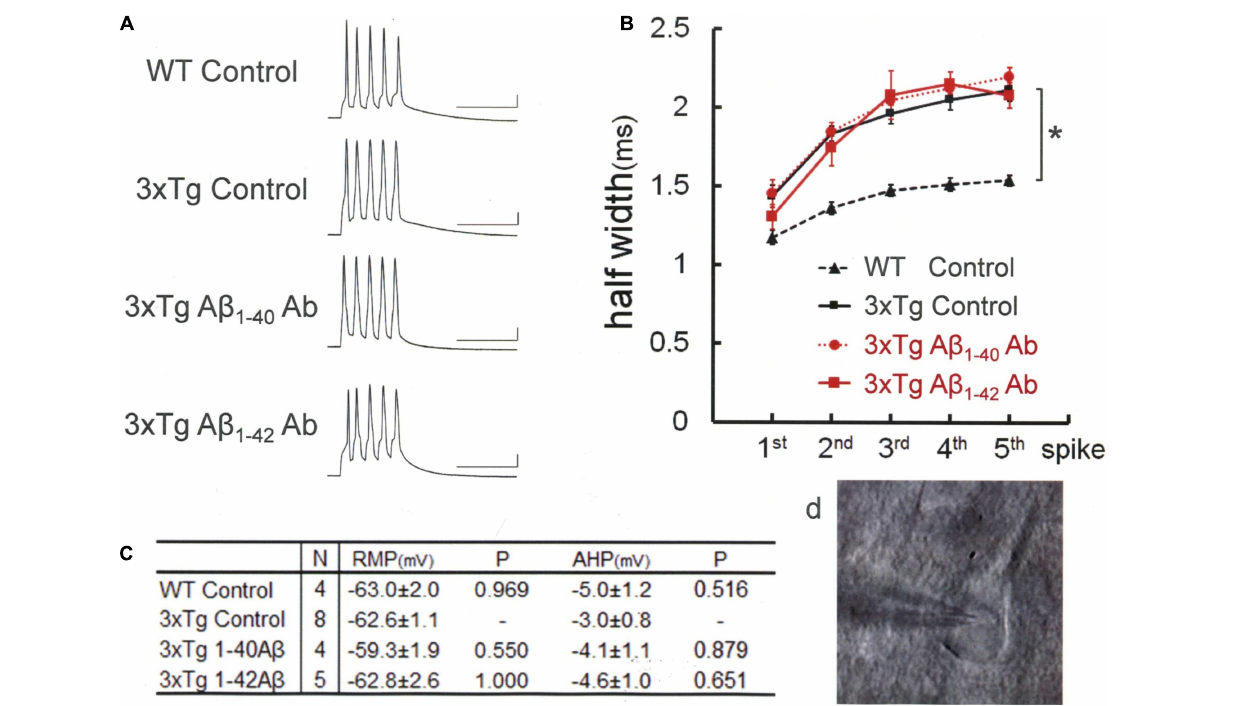
FIGURE 1 | Intracellular injection of antibodies against A β monomer fails to rectify the spike broadening in 3xTg mice neocortex neurons. (A) Recordings of spike trains induced by brief current injections at 100 Hz into neurons in slices obtained from wild-type or 3xTg mice. Scale bars, 50 ms and 20 mV. (B) Averaged spike half-width during the five-spike train [black dashed line and triangle, WT Control; black solid line and square, 3xTg Control; red dotted line and circle, 3xTg A β 1 - 40 antibody (G2-10); red solid line and square, 3xTg A β 1 - 42 antibody (G2-11)]. With A β monomer antibodies, spike half-widths in 5th spikes were much the same as in 3xTg Control and significantly larger than in WT Control (* P < 0.001). Some of the error bars are too short to be seen clearly in this and the following figures. (C) Basic membrane properties of recorded neurons. Resting membrane potential (RMP) and afterhyperpolarization (AHP) were compared by using one-way ANOVA followed by Tukey HSD tests. No significant changes were induced by injecting antibodies or peptides. (D) A bright-field photomicrograph illustrating the arrangement of the pipette on a recorded pyramidal cell under microscope. The following Figures 2 – 5 are illustrated in the same